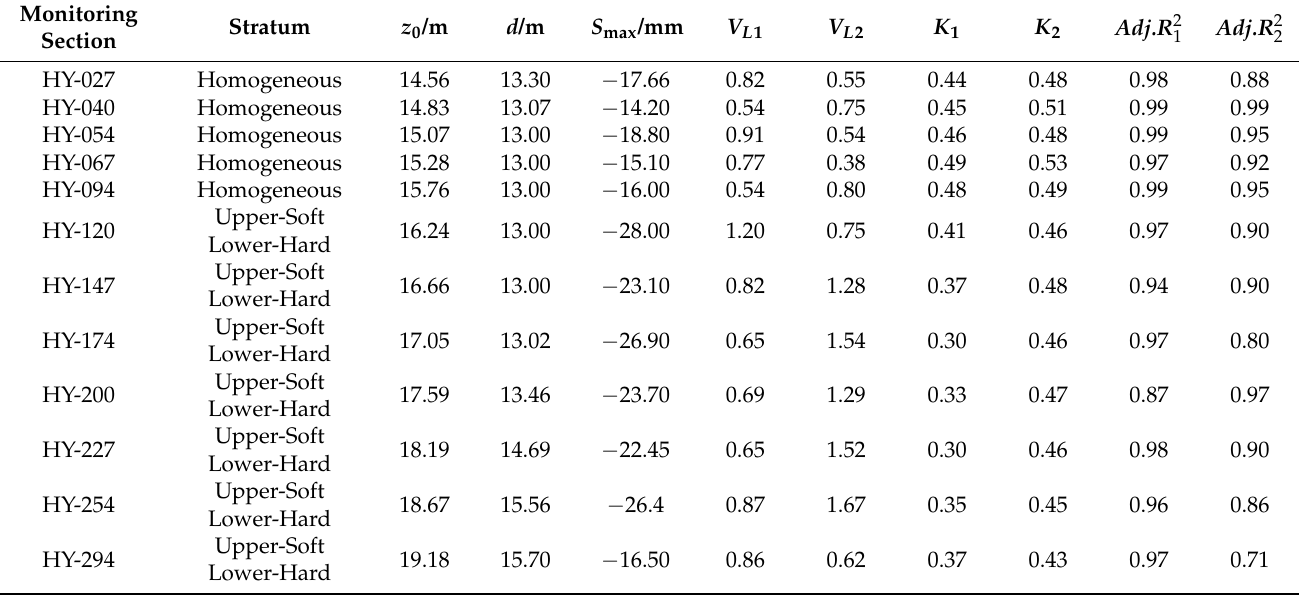
Table 1. Settlement trough fitting results of monitoring